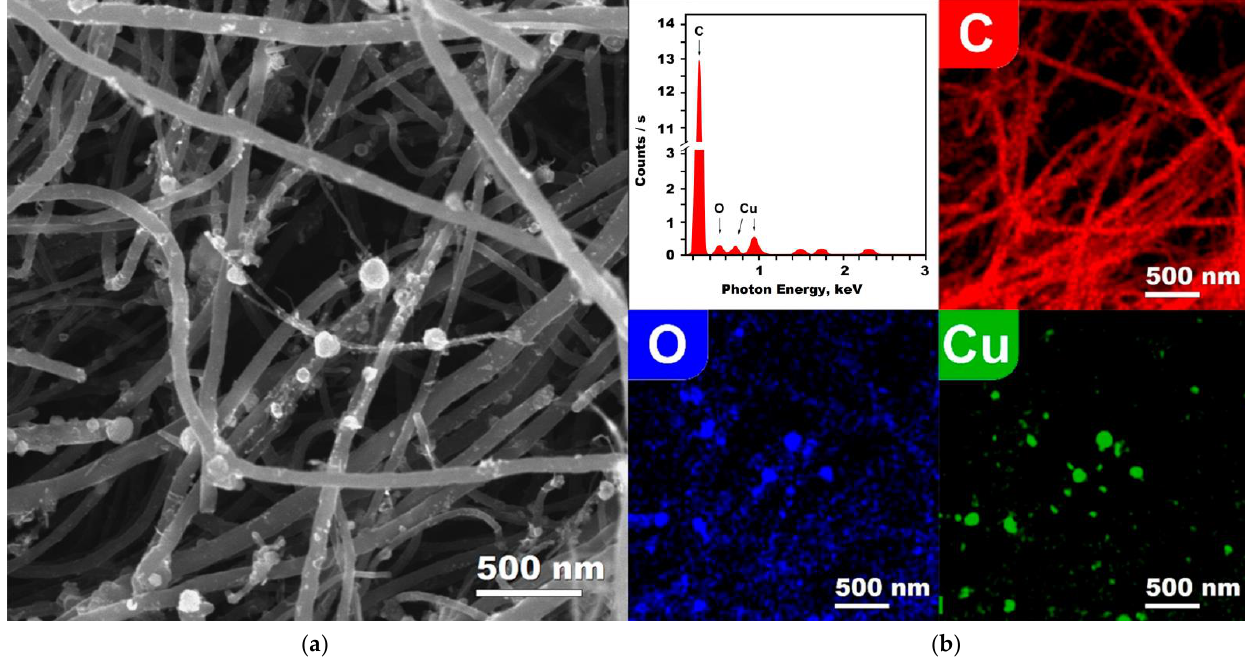
Figure 5. ( a ) SEM image and ( b ) EDS data of the Cu/MWCNTs hybrid nanocomposite: EDS spectrum and maps of spatial distribution of carbon, oxygen, and copper atoms.